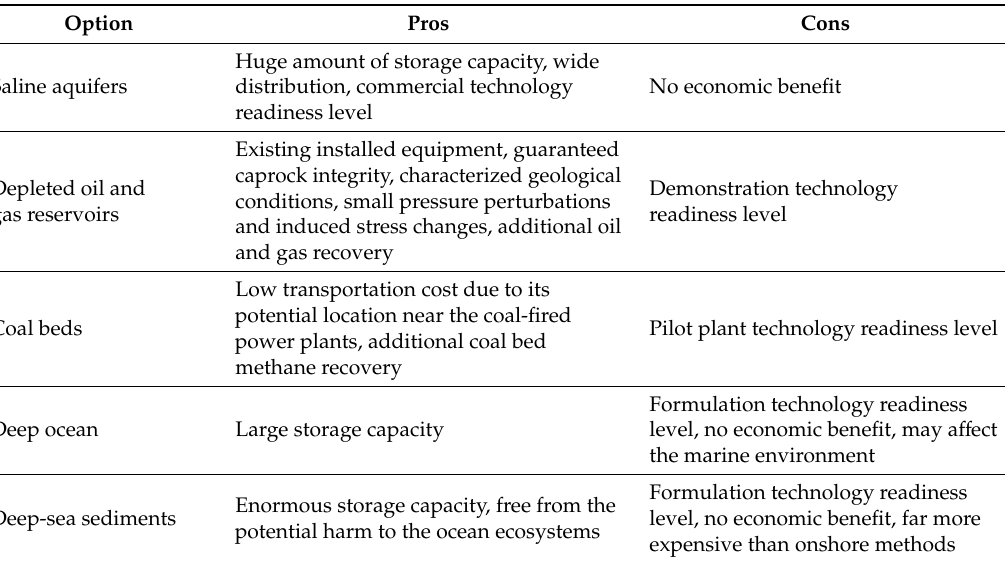
Table 3. The pros and cons of a variety of storage strategies.